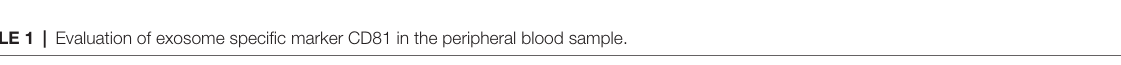
TABLE 1 | Evaluation of exosome specific marker CD81 in the peripheral blood sample. S0 S1 S2 S3